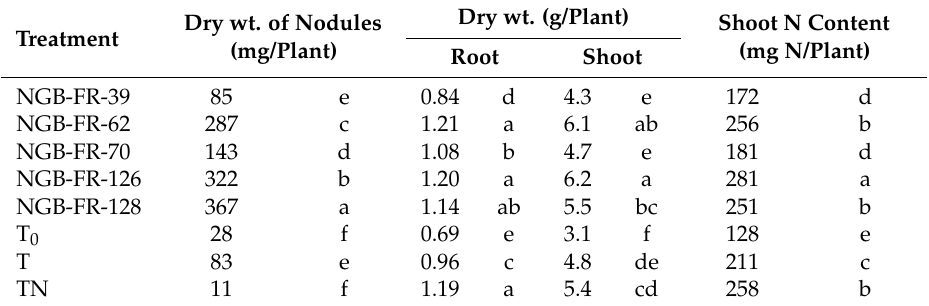
Data per plant are means of four replicates (three plants per replicate). Values followed by the same letter within each column are not significantly different at p < 0.05. T 0 : uninoculated seeds and non-chemical N-fertilizers.